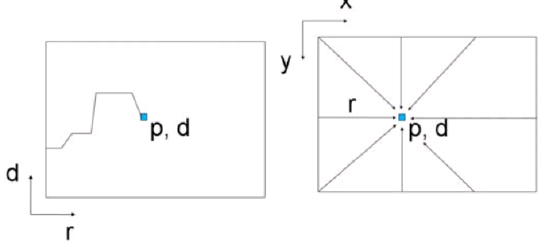
Figure 1. Eight optimization paths (Hirschmüller, 2011)